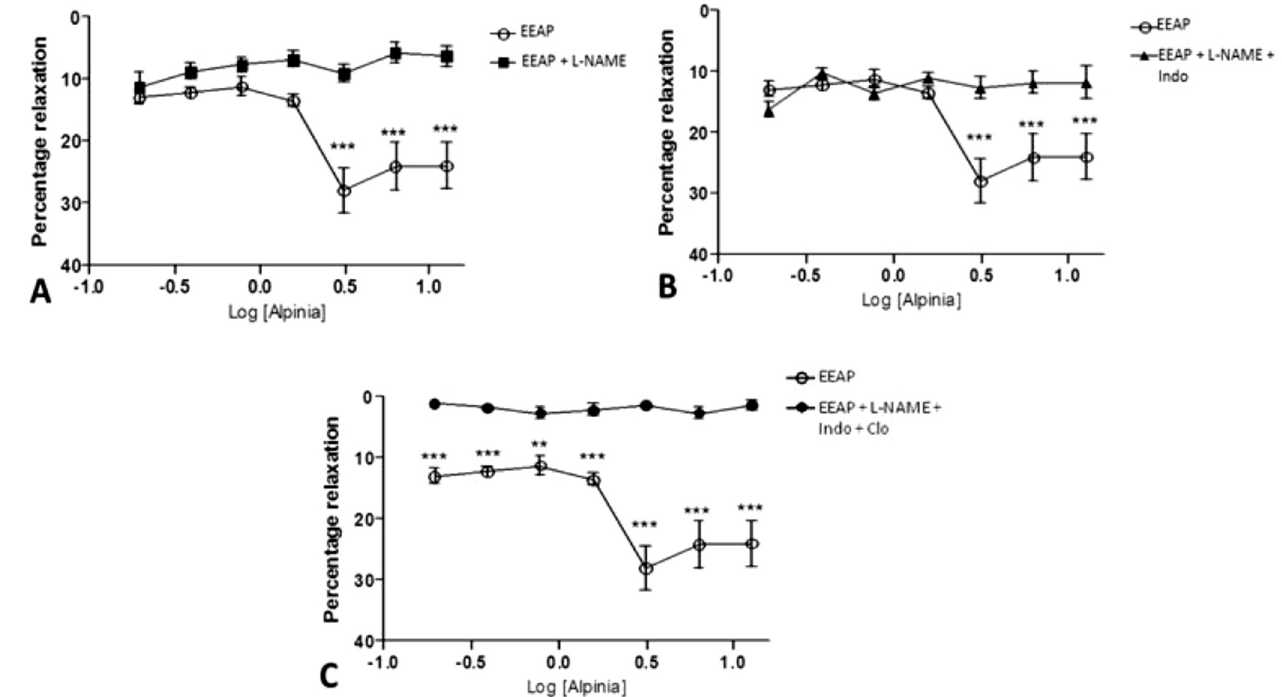
FIGURE 3 - Mesenteric vascular reactivity of EEAP. Panel A: concentration-effect curves of EEAP and EEAP + L-NAME. Panel B: concentration-effect curves of EEAP and EEAP + L-NAME + indomethacin (Indo). Panel C: concentration-effect curves of EEAP and EEAP + L-NAME + indo + clotrimazole (Clo). Values are expressed as the mean ± SEM. ** p < 0.01 and *** p < 0.001 compared with values of EEAP with